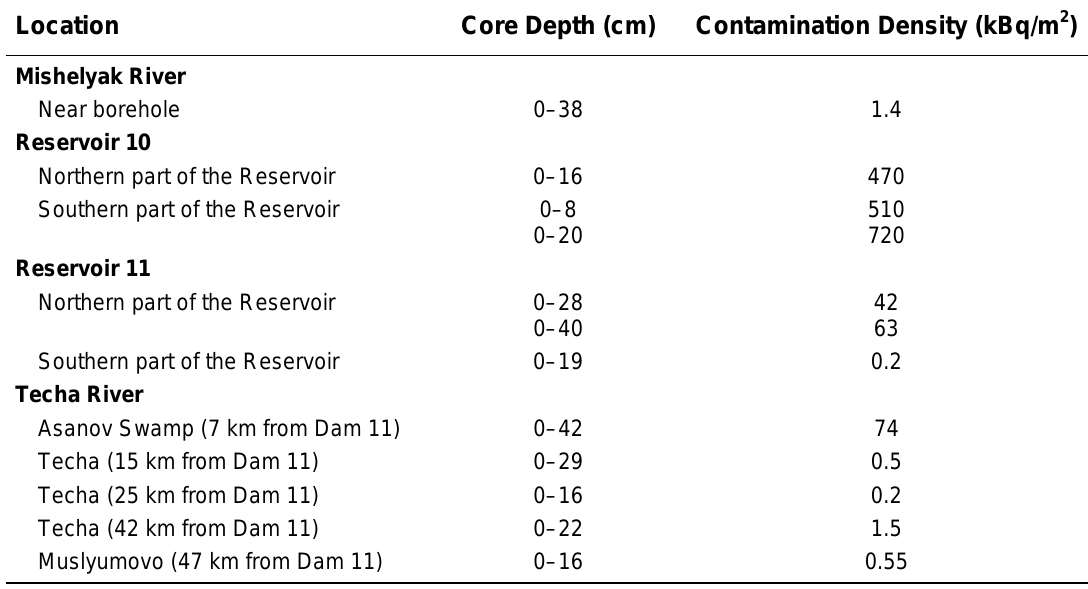
Mean Sediment Contamination Densities (Bq/m 2 ) in the Mayak